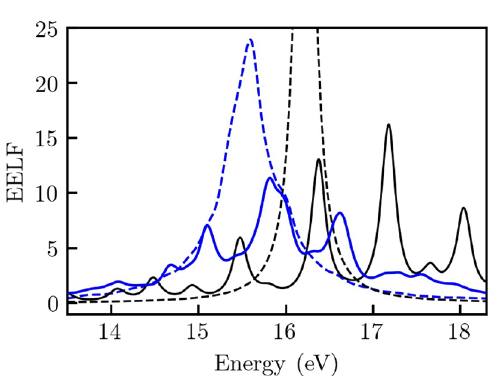
Figure 5. The emergence of novel modes of electronic excitations in isochorically heated aluminum. The EELF for aluminum at U 0 = 0.1 , T = 1.25 eV along wave vector Q in the presence of externally imposed inhomogeneity (solid blue) and in the absence of the perturbation (dashed blue) at ( q = 0.34 Å − 1 ). The results for the uniform (solid black) and perturbed electron gas (dashed black) at q = 0.37 Å − 1 are shown for